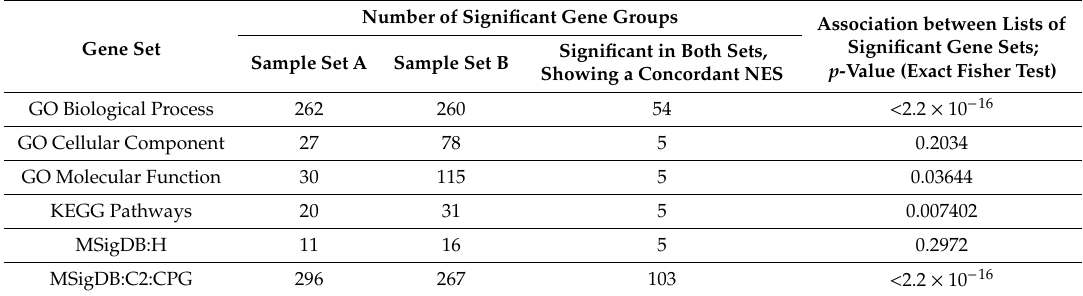
Table 2. Comparison of significant gene sets in gene set enrichment analysis (GSEA) of Sample set A and Sample set B.